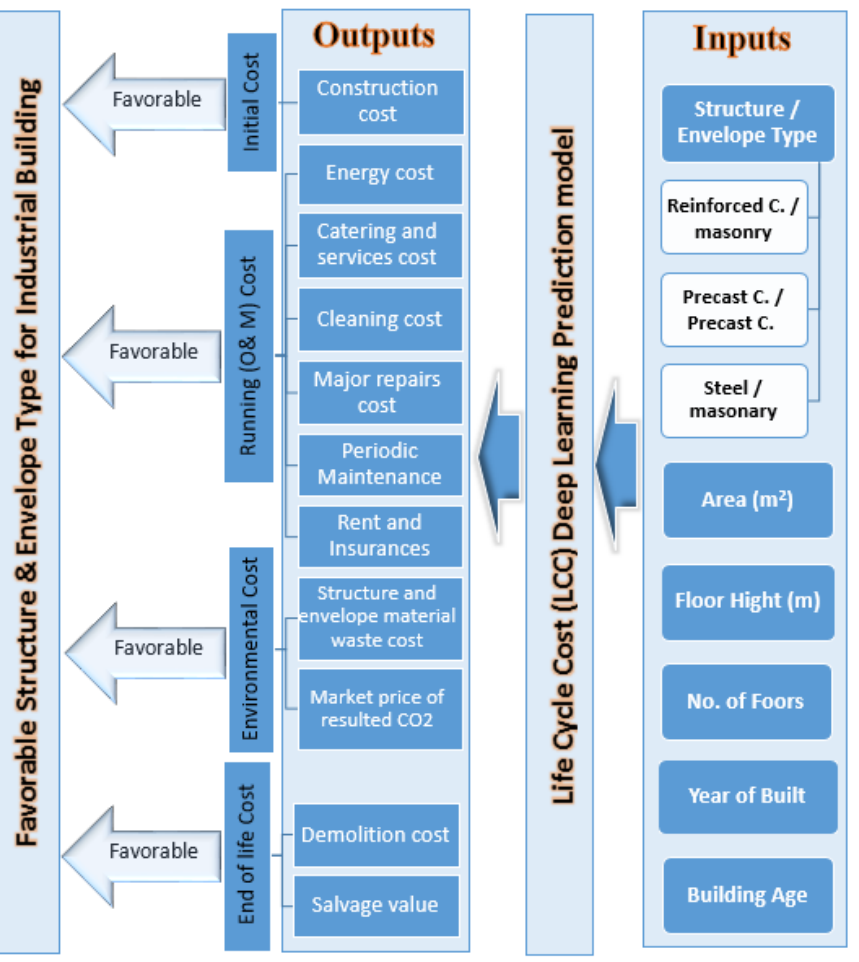
Figure 1. Applied LCC prediction model framework needed for selecting the favorable structure and envelope type of industrial buildings.